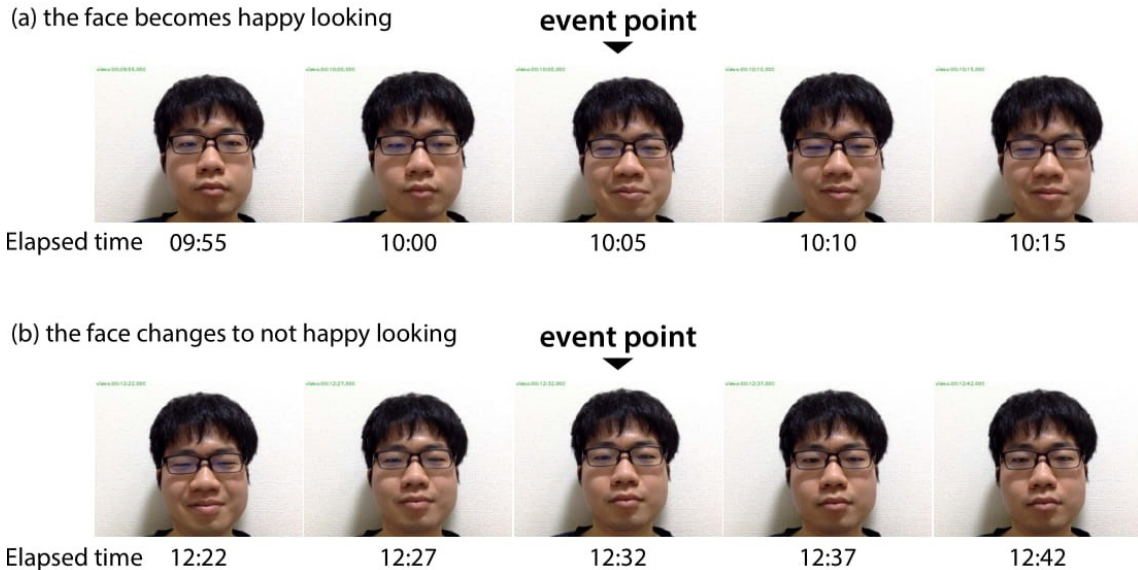
Figure 6. Example of event points ( a ) the face becomes happy looking, ( b ) the faces changes to not happy looking. (“Elapsed time” corresponds to change score graphs in Figure